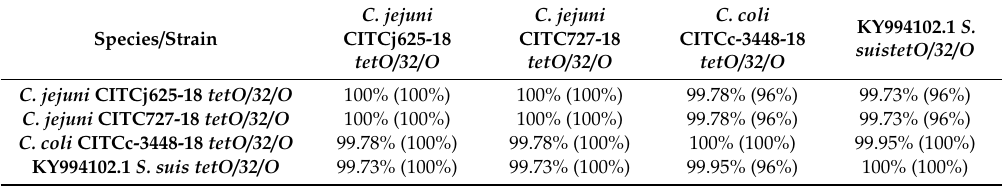
Table 2. Percentage identity (percentage cover in brackets) of mosaic tetracycline resistance gene ( tetO / 32 / O ) type II in three tetracycline-resistant Campylobacter spp. isolates detected in this study and